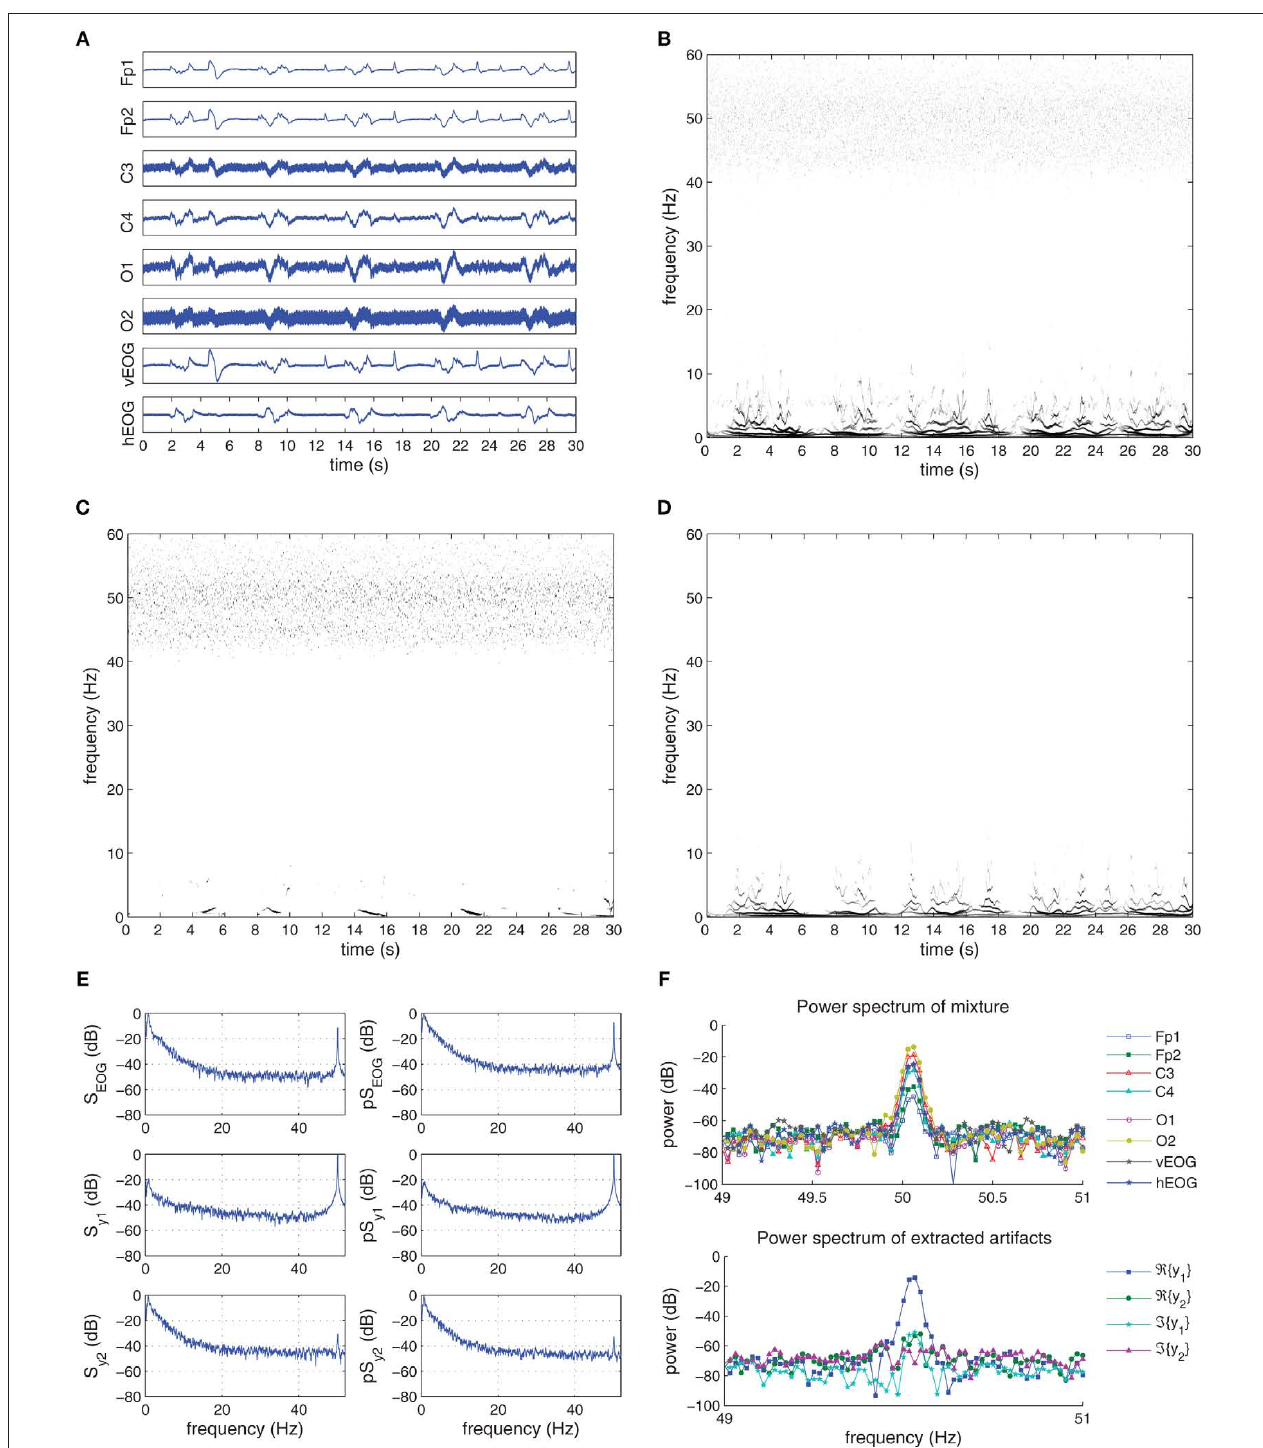
FiGurE 11 | recorded and extracted artifacts from the “ E yEroll ” set. (A) Recorded EEG signals from the “ E yEroll ” set. (B) The Hilbert– Huang time–frequency plot of the recorded EEG signals. (C) The Hilbert– Huang time–frequency plot of the extracted line noise R { y Hilbert–Huang time–frequency plot of the extracted EOG R { y